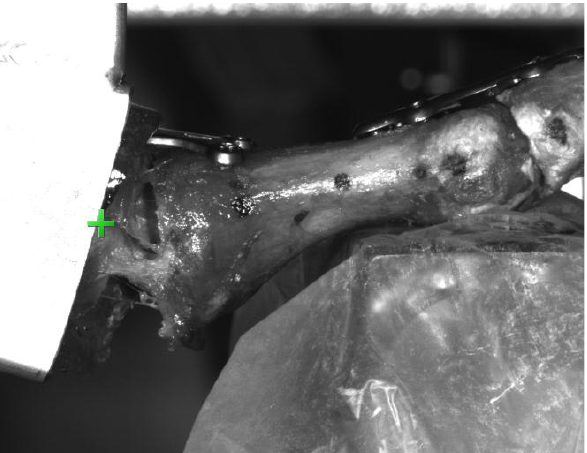
Fig. 10. Joint gapping in specimen 6 after application of 30N force, PP fixation.